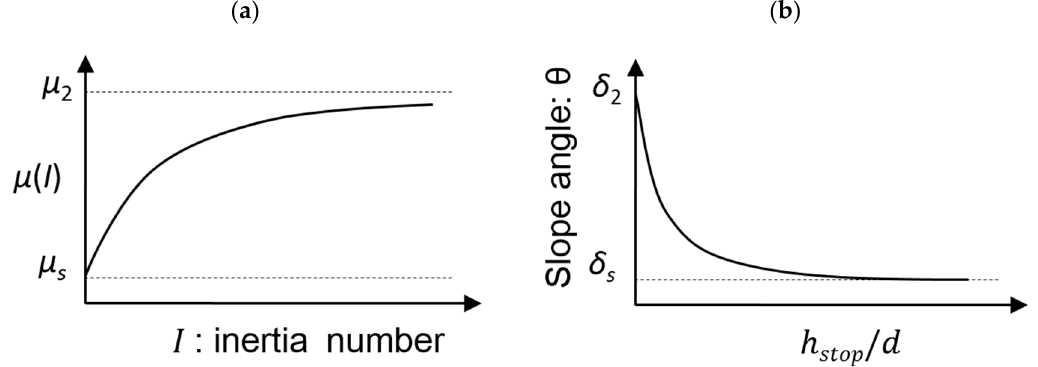
Figure 13. Schematic graph showing ( a ) the relationship between µ s and µ 2 against the inertia number, and ( b ) the relationship between δ 2 and δ s against h stop / d . h stop is the minimum thickness, below which no flow occurs. Graph ( a ) was drawn based on Figure 1 of [28], and graph ( b ) was based on Figure 2c of [37].